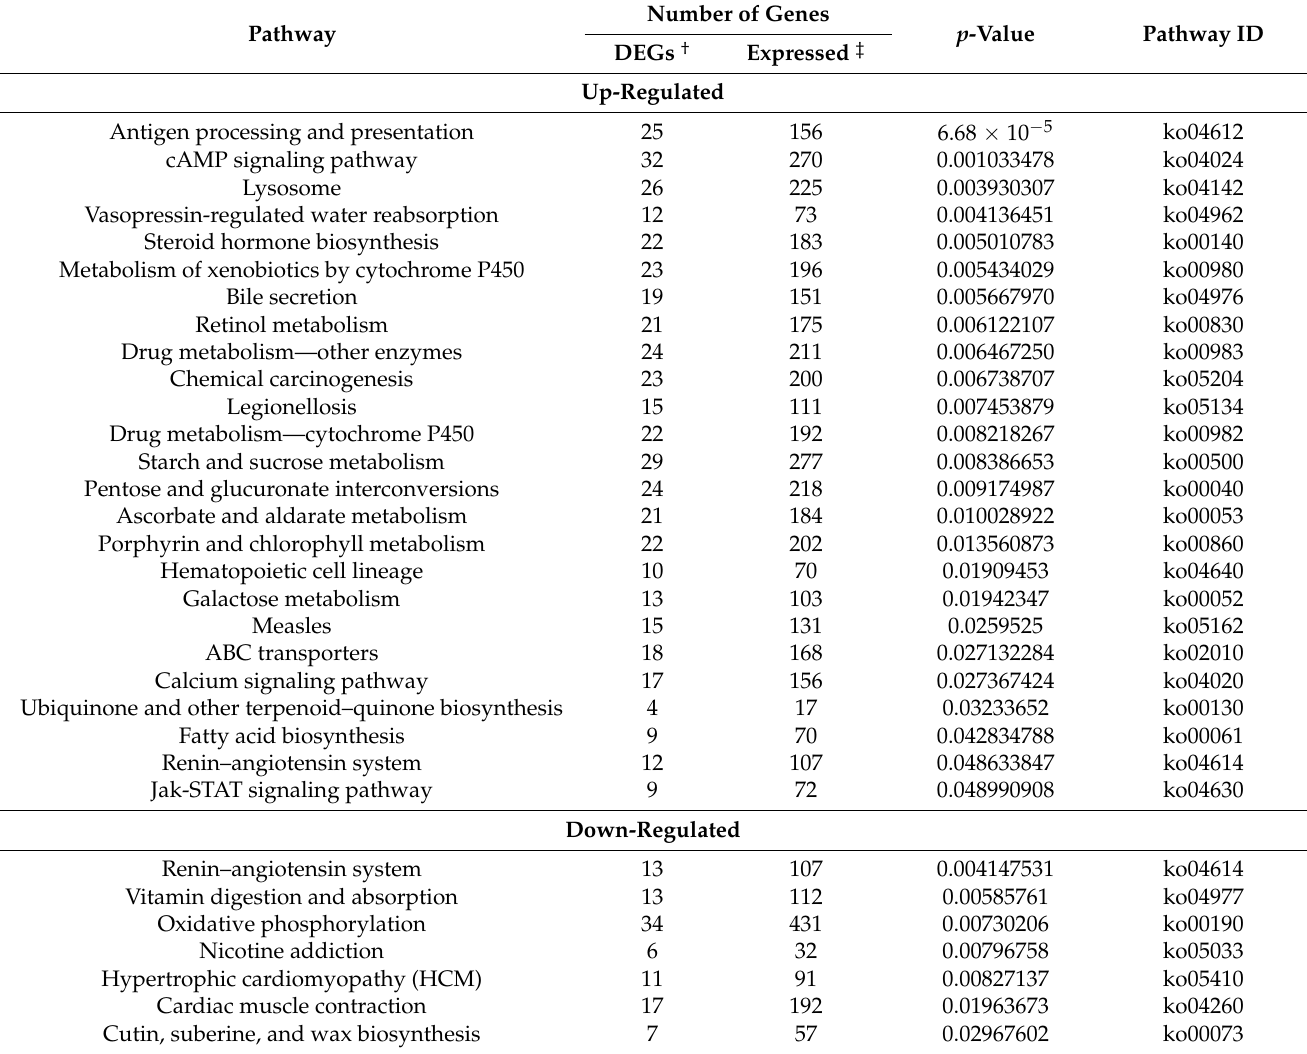
Table 1. Significantly enriched KEGG pathways in the transcriptome of M. persicae adults infected with cucumber mosaic virus